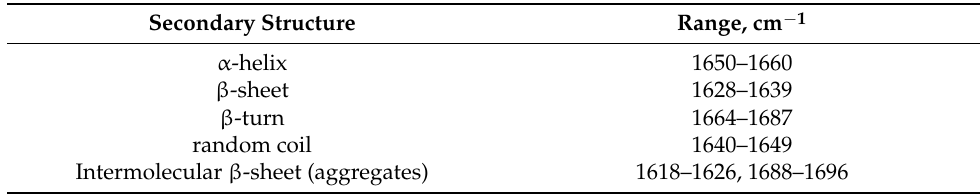
Table 5. Correlation between BSA secondary structure and amide I second derivative position 1